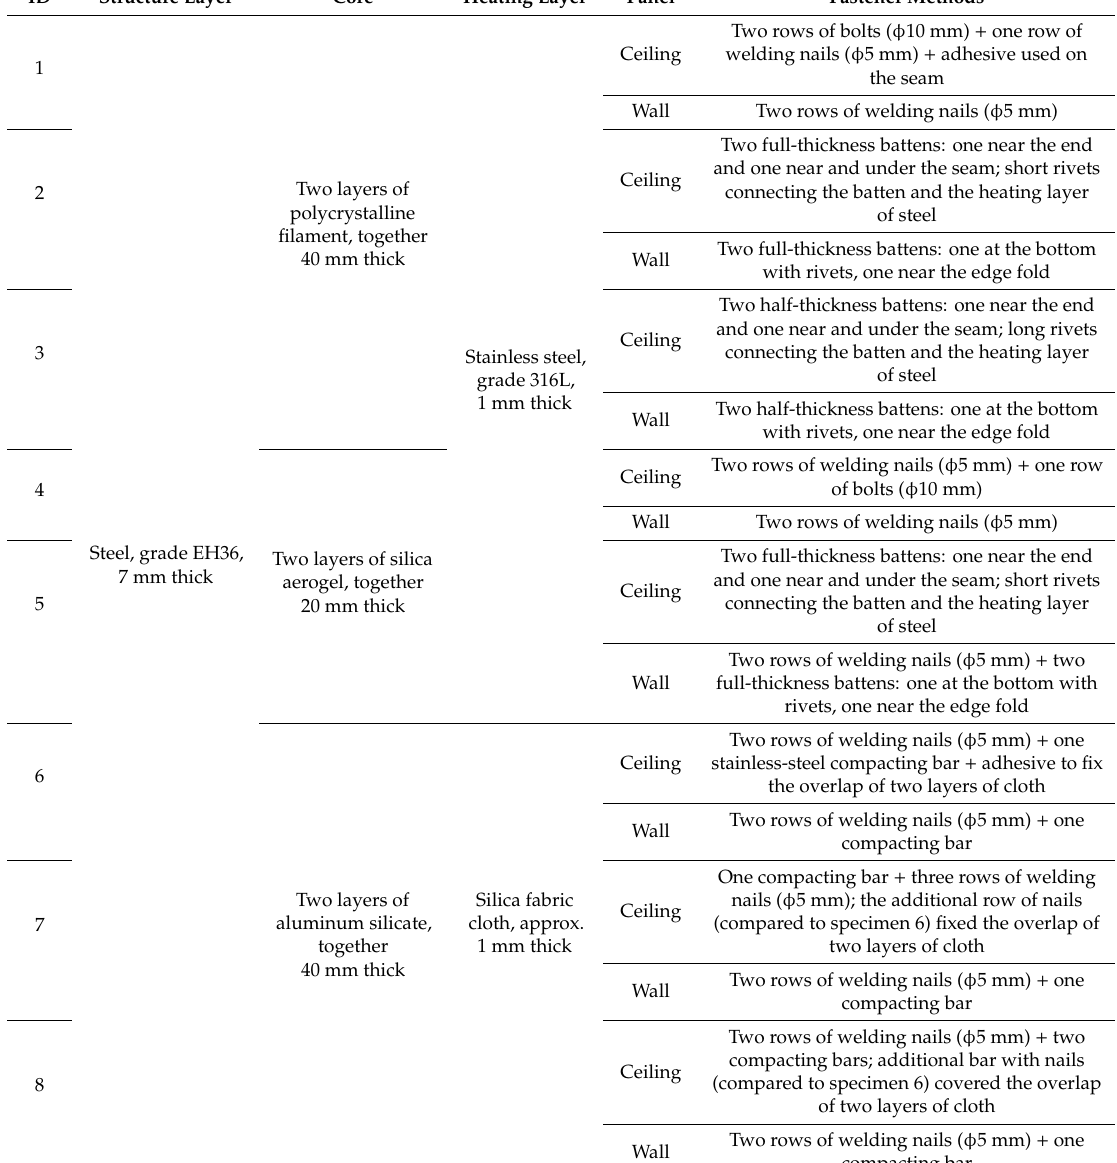
Table 1. Materials and fabrication methods used in